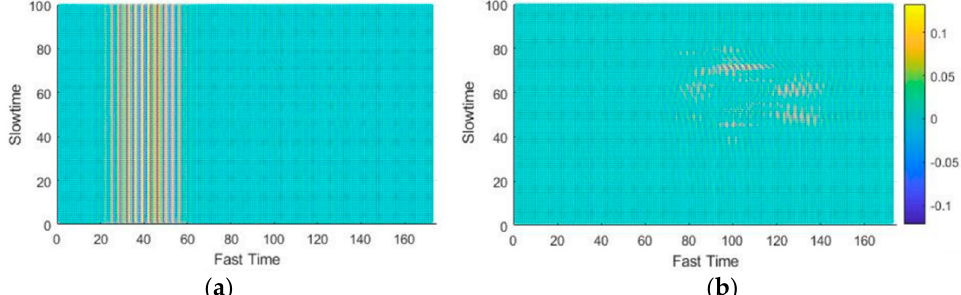
Figure 12. Clutter removal when radar placed near driver’s head: ( a ) signal before removal and ( b ) signal after removal.